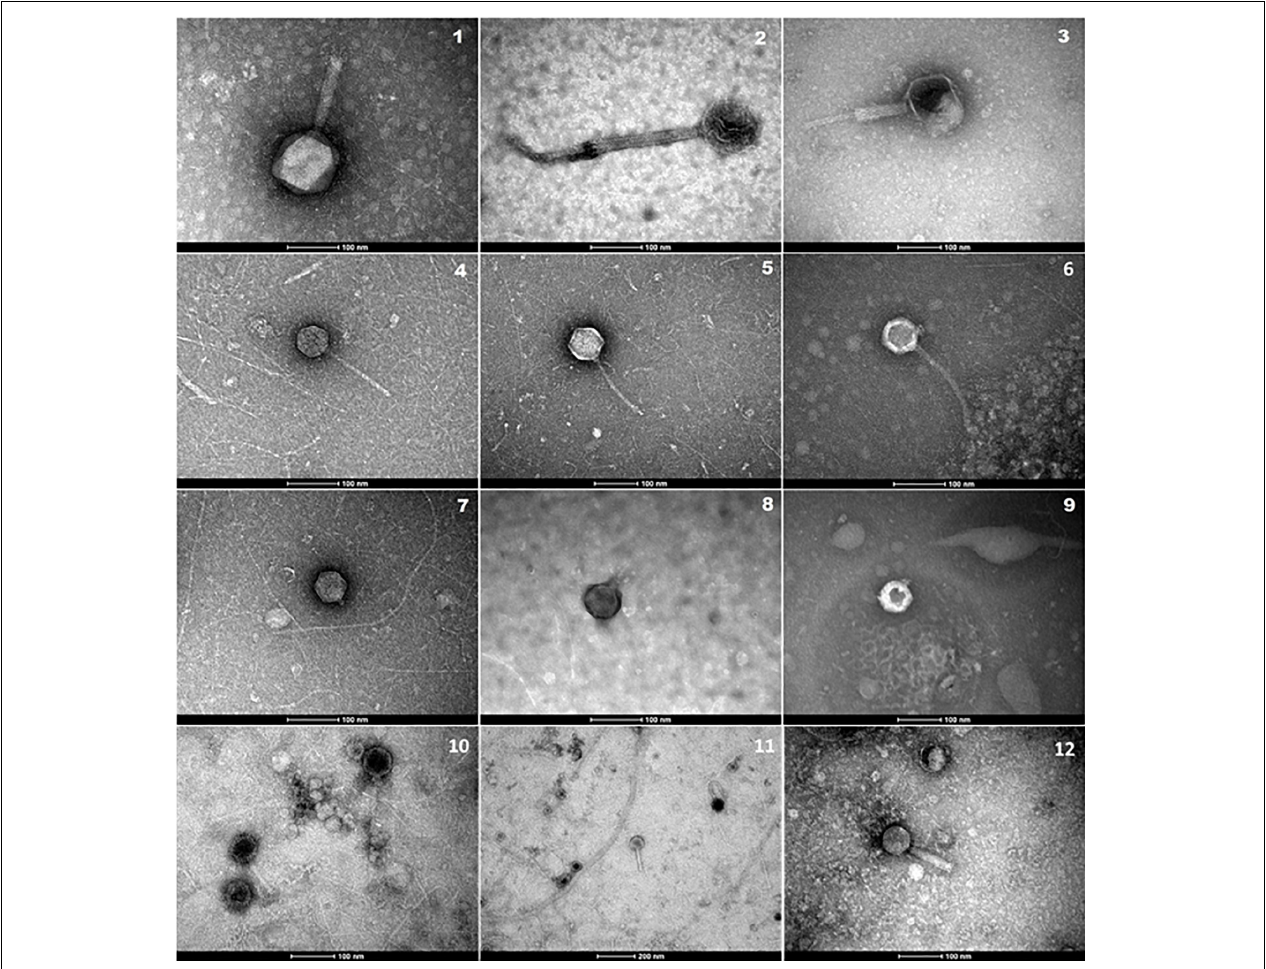
FIGURE 4 | Electron micrographs showing bacteriophages isolated in concentrated water samples from Elm Park Stream (1, 4, 5, 7, 11), River Tolka (2, 8, 10), Trimleston Stream (6, 9), and raw sewage (3, 12). Images 1–3 show Myoviridae phages, images 4–6 Siphoviridae phages and images 7–9 Podoviridae phages. Scale bars represent 100 nm, whereas the scale bar in micrograph-11 represents 200 nm.